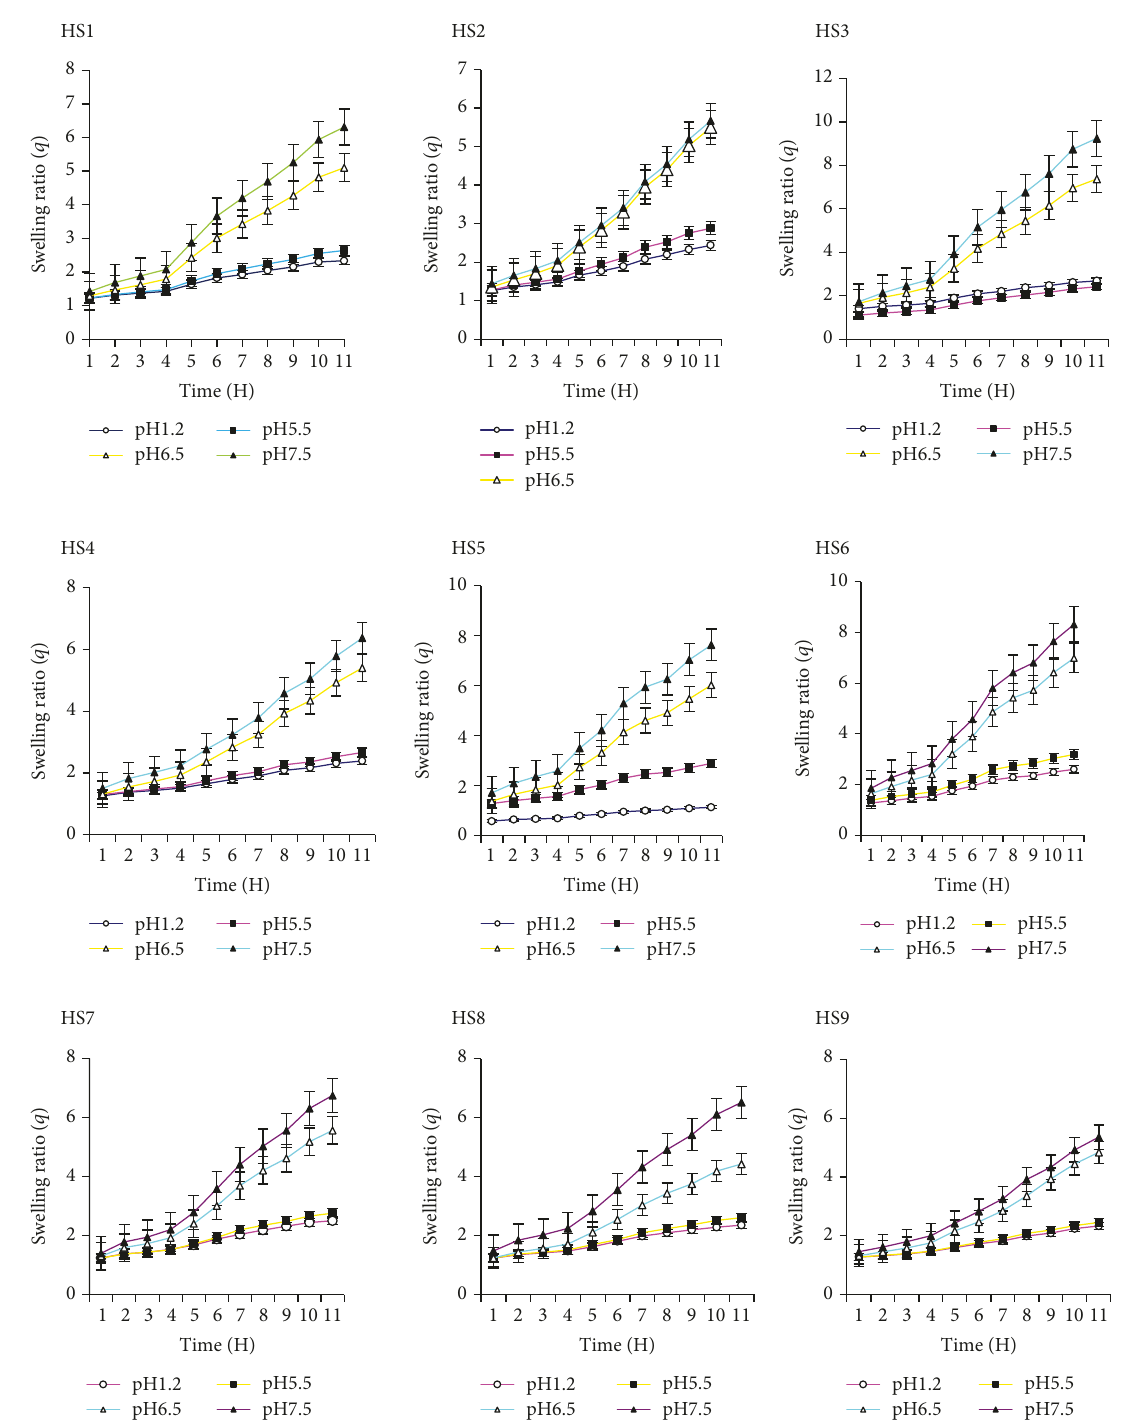
Figure 1: Dynamic swelling coe ffi cient ( q ) of all hydrogel samples (HS1-HS9) in various 0.05M USP phosphate-bu ff ered solutions at 37 °